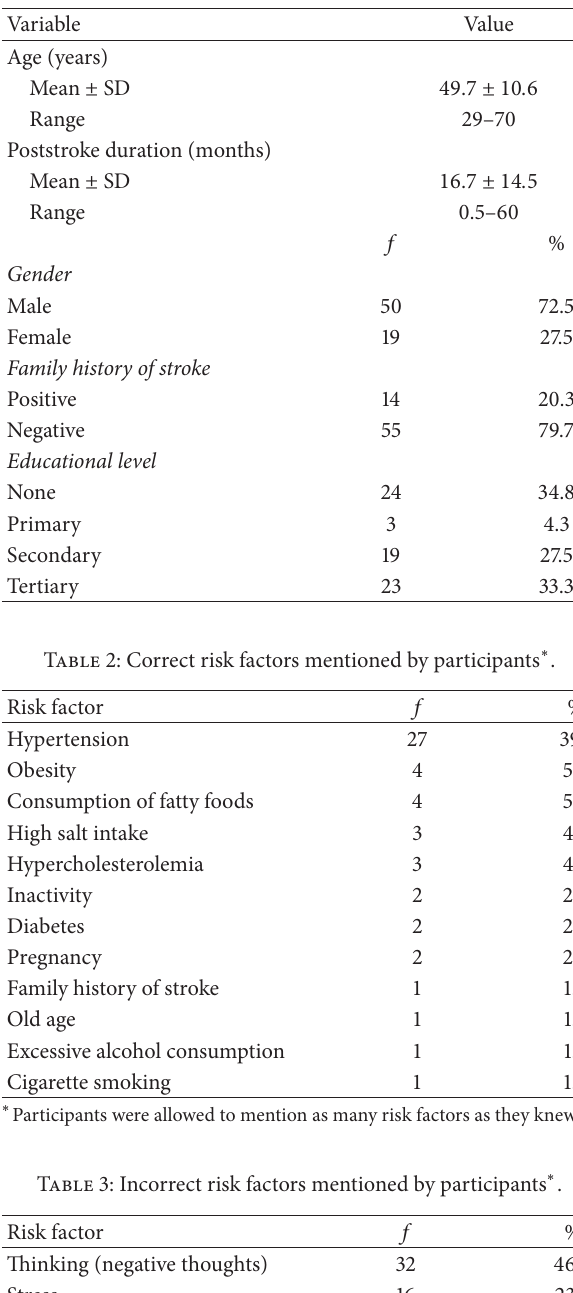
Table 1: Characteristics of the participants ( 𝑁 = 69 ).